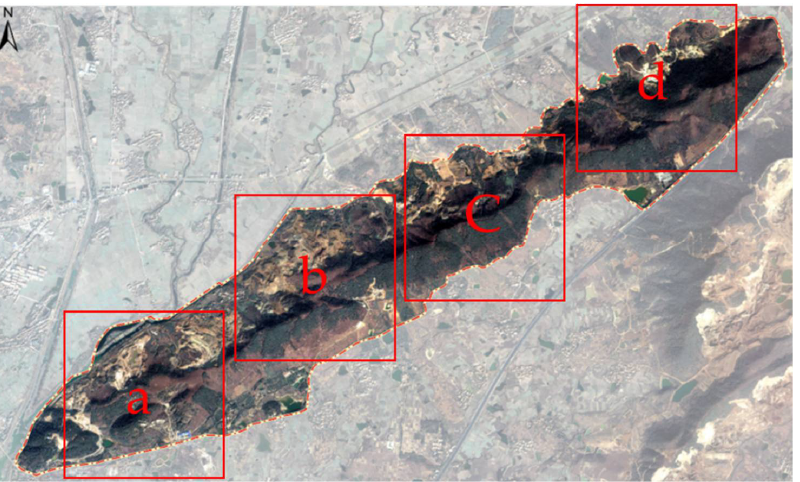
Figure 24. Recognition areas.( a ) Satellite image slice named recognition area “a”. ( b ) Satellite im- age slice named recognition area “b”. ( c ) Satellite image slice named recognition area “c”. ( d ) Satel- lite image slice named recognition area “d”